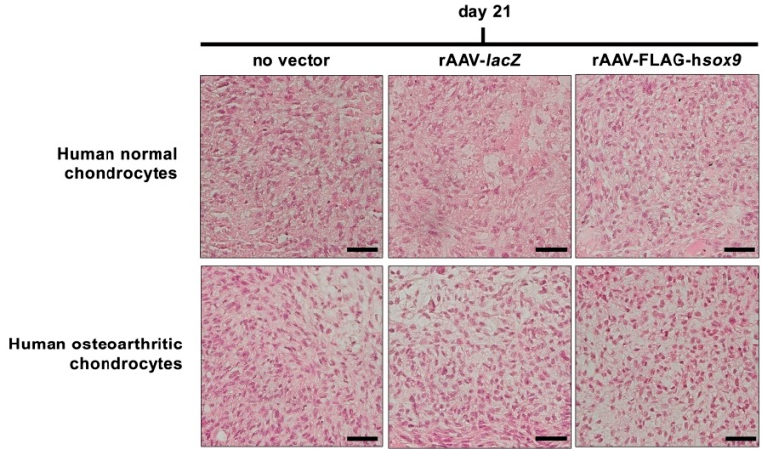
Figure 4. Cell proliferation in rAAV-transduced aggregate cultures of human normal and OA chondrocytes. Cell aggregates were transduced with rAAV-FLAG-h sox9 versus rAAV- lacZ (40 µ L each vector) or lack of vector treatment as described in Figures 1–3 and in the Materials and Methods. Cell proliferation was monitored after 21 days by H&E staining as described in the Materials and Methods (magnification x40; all representative data). Scale bars: 20 µ m. Table 2. Biochemical analyses in rAAV-transduced aggregate cultures of human normal and OA chondrocytes (day 21).